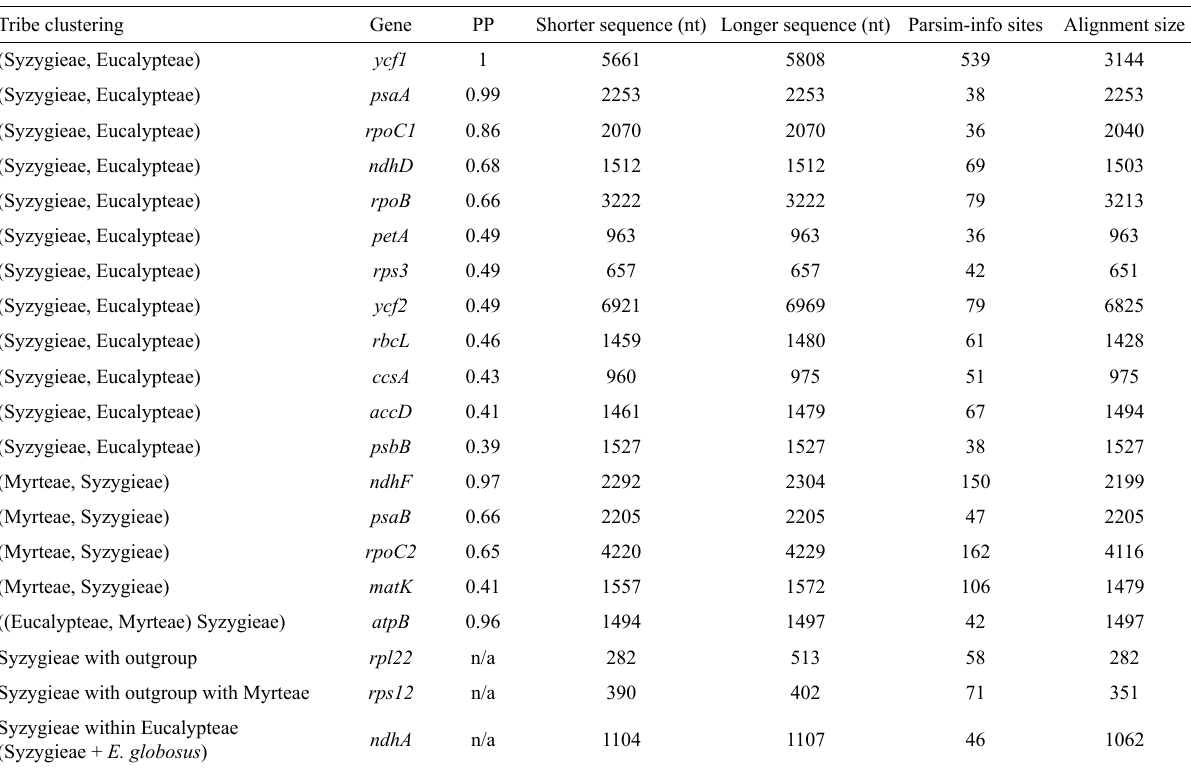
Table 1 – Twenty plastid genes used for concordance analysis due to their phylogenetic effectiveness, ranked according to the tribe grouping, they reconstruct and the posterior probability of the branch. Tribe clustering Gene PP Shorter sequence (nt) Longer sequence (nt) Parsim-info sites Alignment